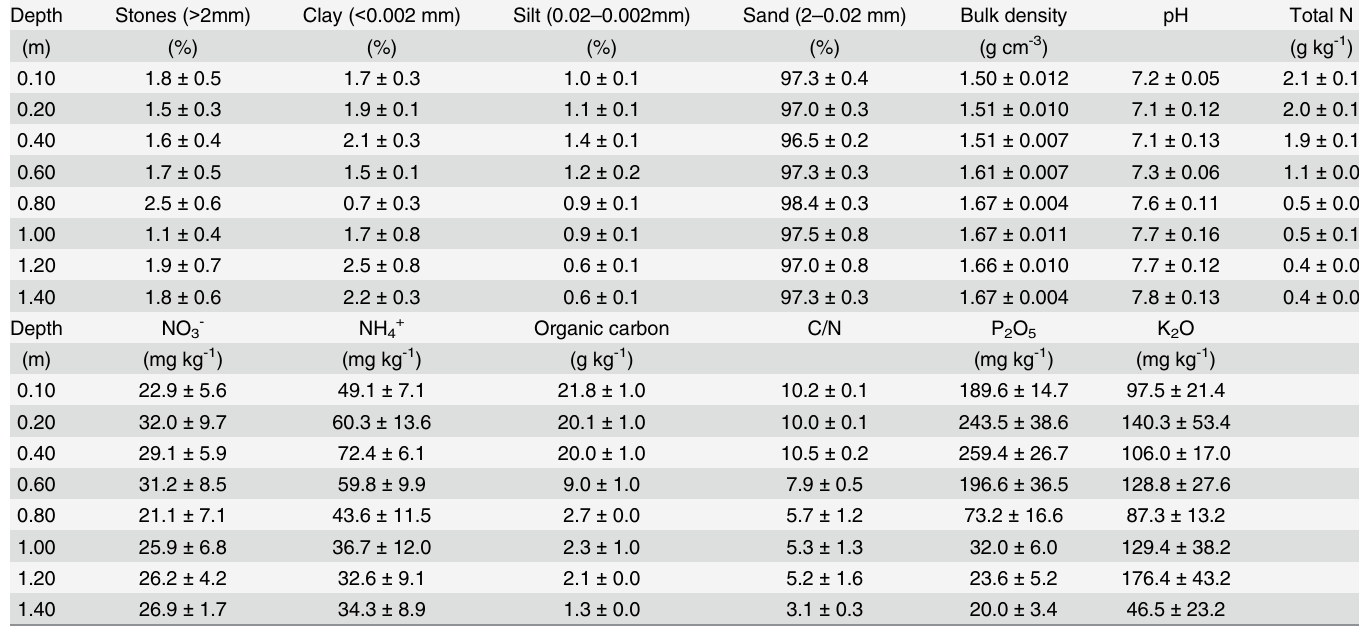
Table 3. Soil physical and chemical characteristics for each layer of the soil profile (means and standard errors, n = 3). Soil samples were collected June 3, 2010, before fertilization and sowing. Depth